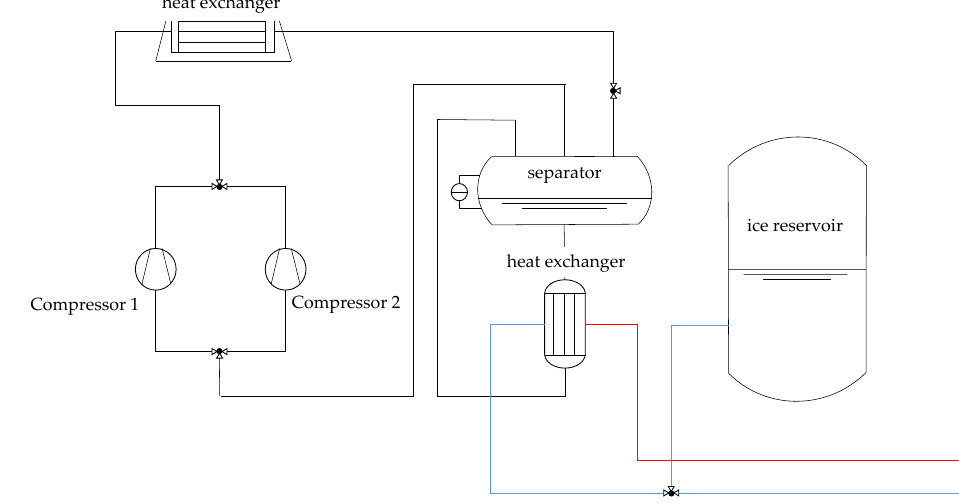
Figure 10. Setup of the energy flexible cooling